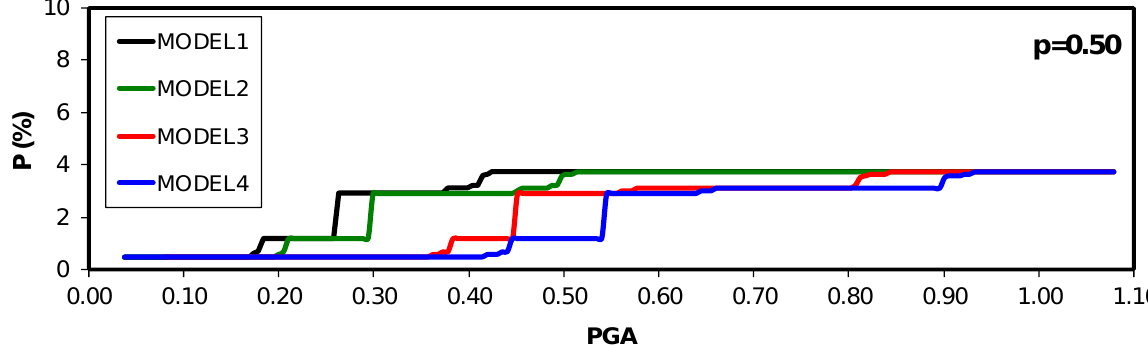
Figure 10. Indirect losses due to prolongation of time (P). Scenario 3: p 2